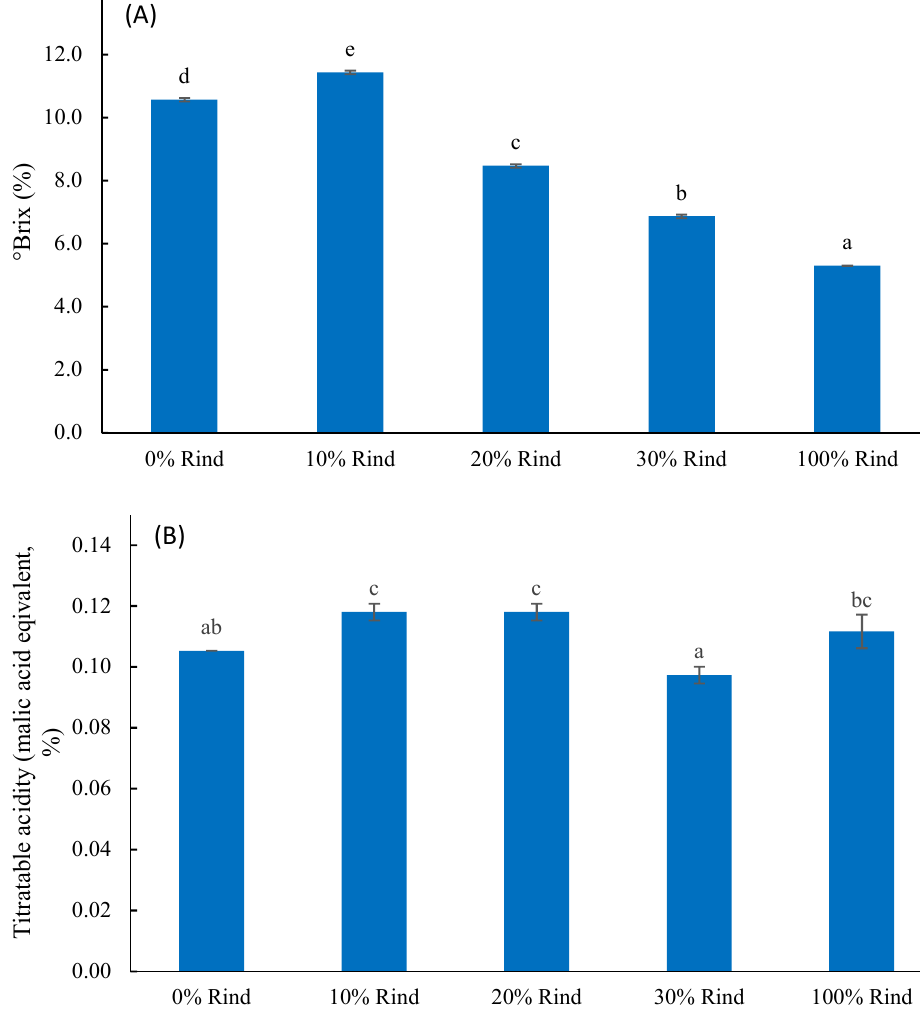
Figure 2. Mean values of ◦ Brix ( A ) and titratable acidity ( B ) (TA, reported in % malic acid equivalents) in watermelon rind, flesh, and rind-flesh blends. Different letters (a–d) among five samples indicate significant differences according to one-way ANOVA and Tukey’s HSD test with p ≤ 0.05. Watermelon acidity could be measured by titratable acidity (TA, the total acid concen- tration). This study showed the TA, reported in malic acid equivalents, ranged